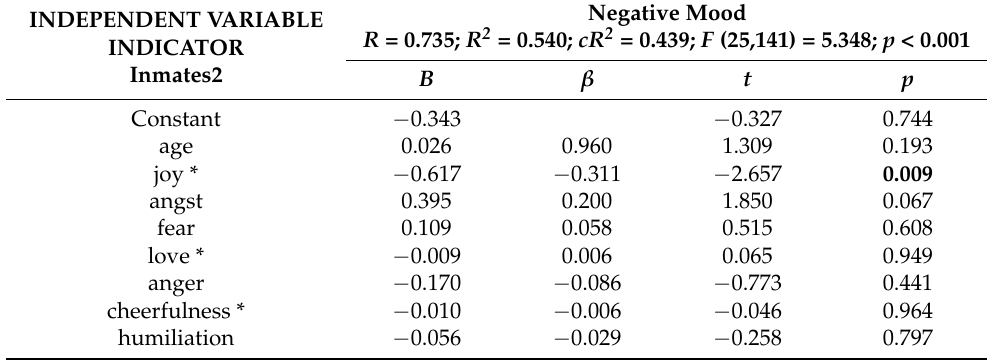
Table 9. Linear regression results, the dependent variable of negative mood in